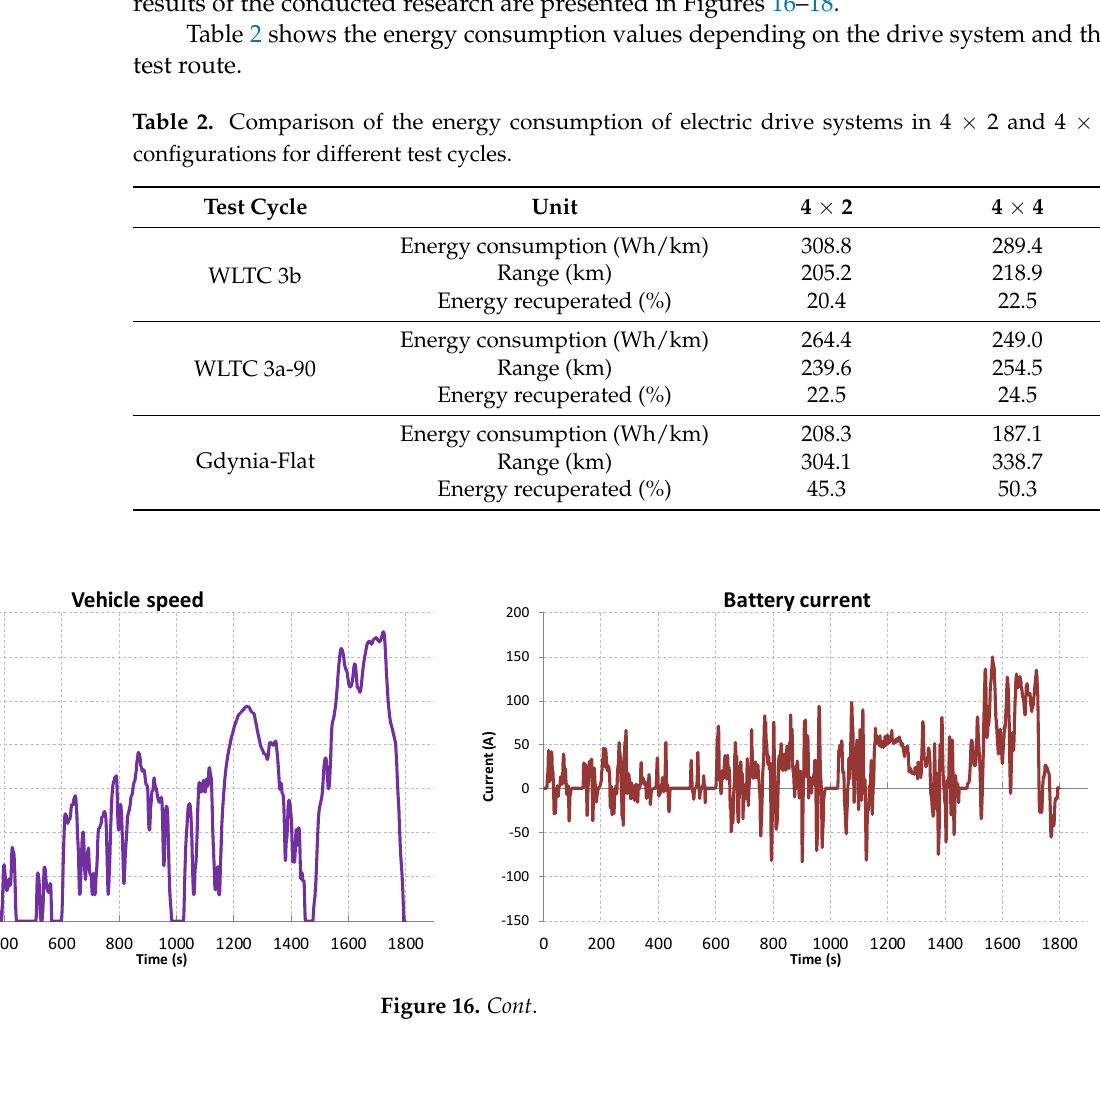
Table 2. Comparison of the energy consumption of electric drive systems in 4 × 2 and 4 × 4 config- urations for different test